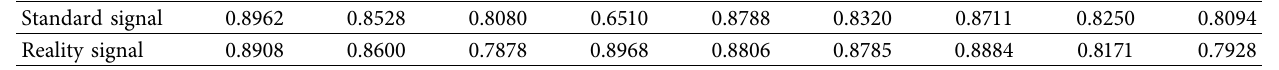
Table 2: Comparison of the standard signal and the actual signal feature